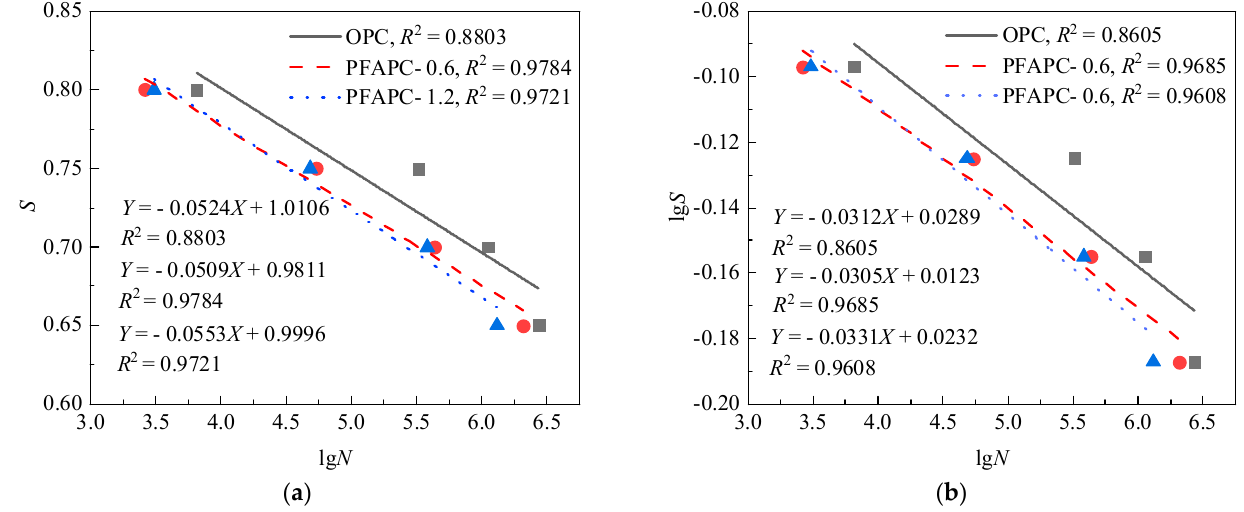
Figure 7. Average life S–N curve: ( a ) single-logarithm and ( b ) double-logarithm fatigue equations.